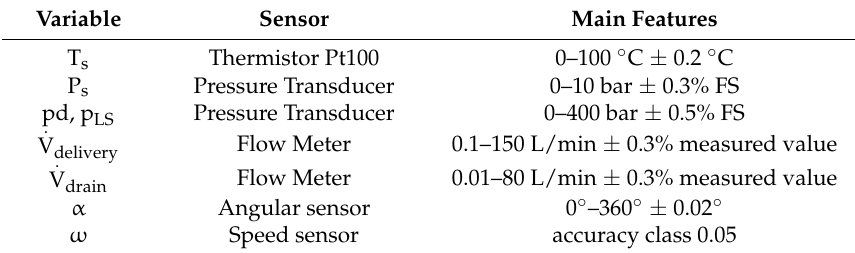
Figure 7. Scheme of the experimental layout. Table 2. Transducers features.